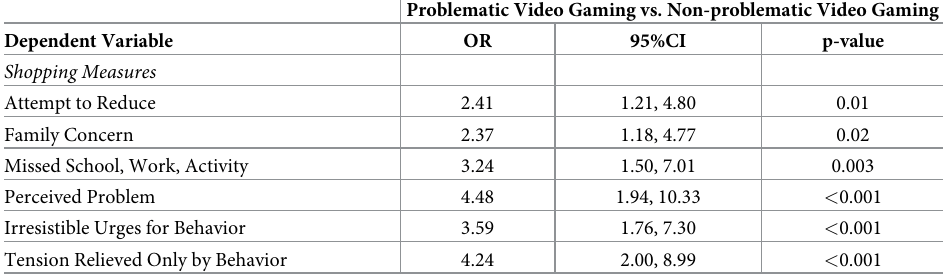
Table 5. Adjusted multivariate analysis of problematic video gaming in adolescents stratified by each problem- atic-shopping measure.